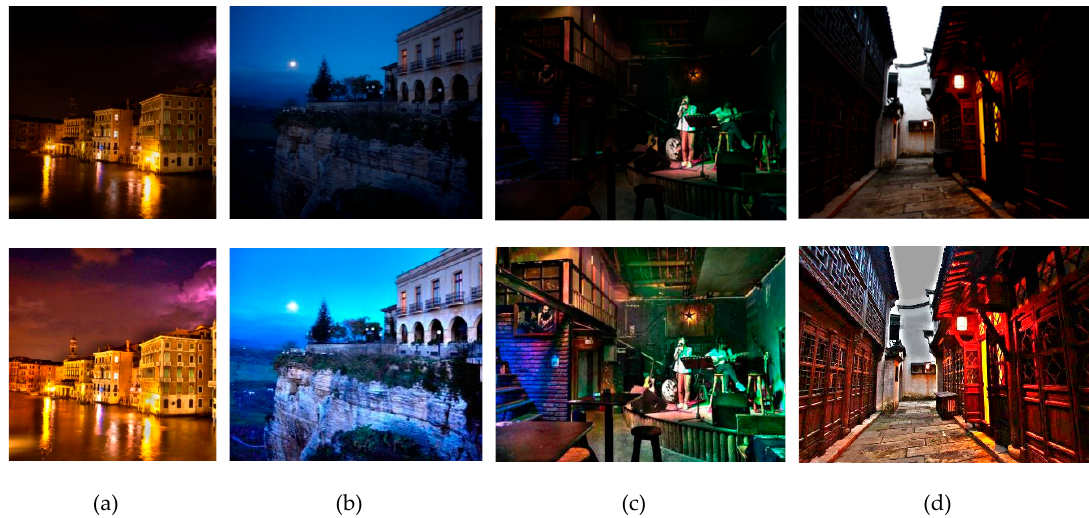
Figure 18. Low illumination color image enhancement process.